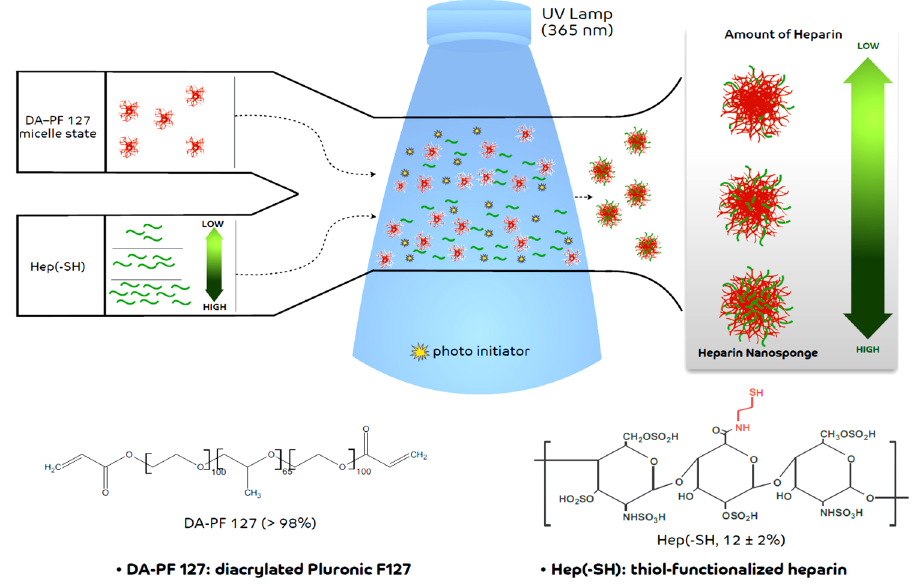
Figure 1. Schematic description of the preparation of photo-crosslinked heparin nanosponges (Hep-NS).